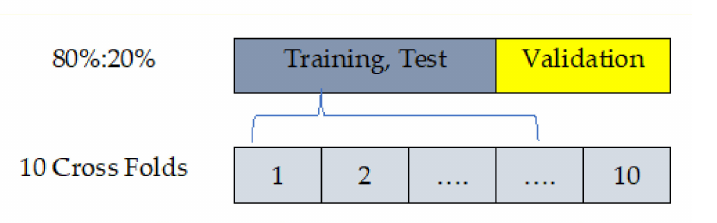
Figure 7. The training, testing, validation, and 10-cross-fold validation of the applied PIDD dataset.